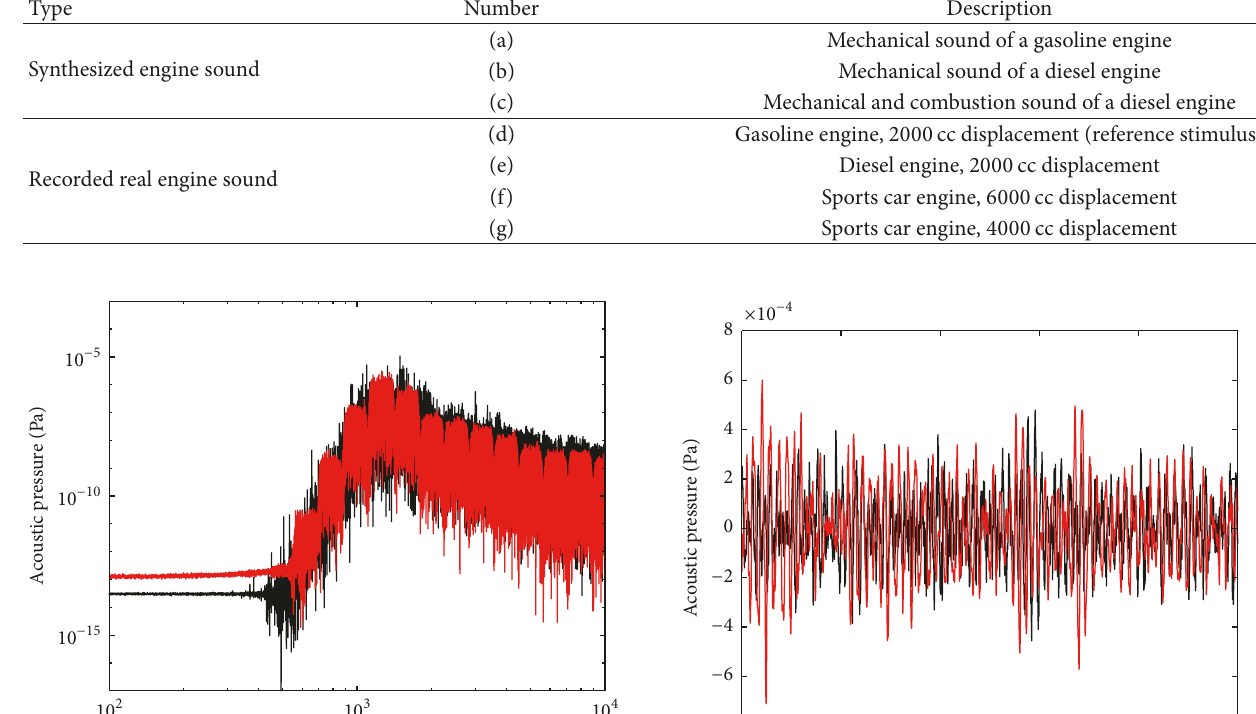
Table 1: Stimuli used in the auditory experiments.